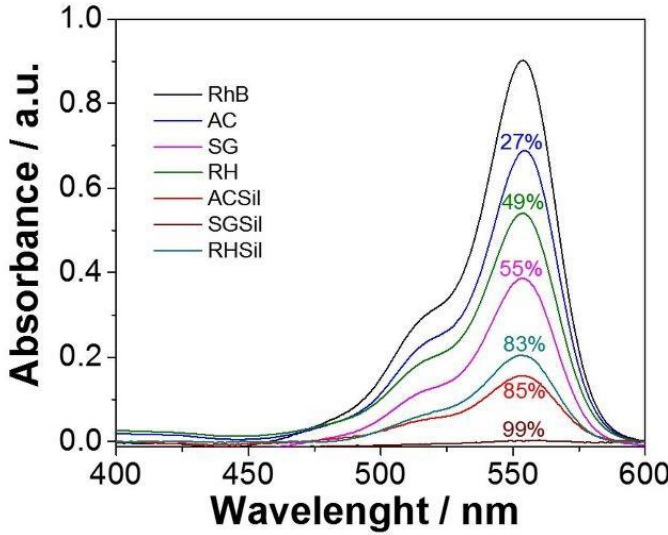
Figure 6. RhB dye adsorption by nanoparticles with unmodified and modified SiO 2 surfaces after 24 h.